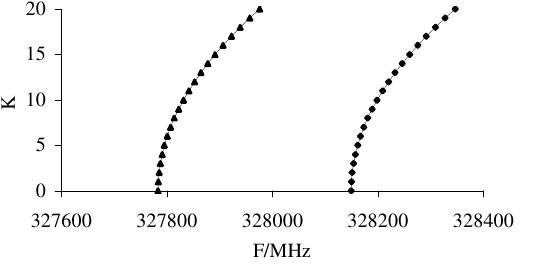
in ground and v 3